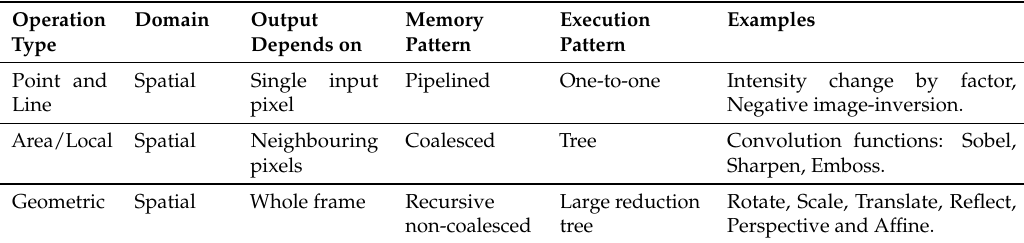
Table 1. Categorisation of image processing operations based on their memory and execution patterns [13] allow features of compute and memory patterns to be highlighted and therefore identifying what can be mapped into